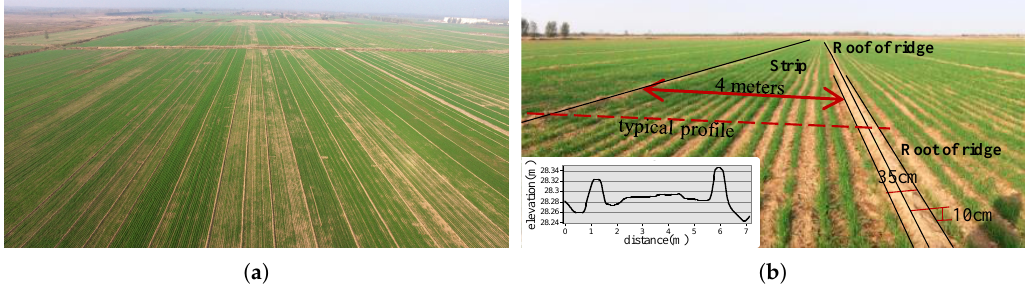
Figure 1. Typical cropland landscape of ( a ) aerial view and ( b ) field photo of actual strips and